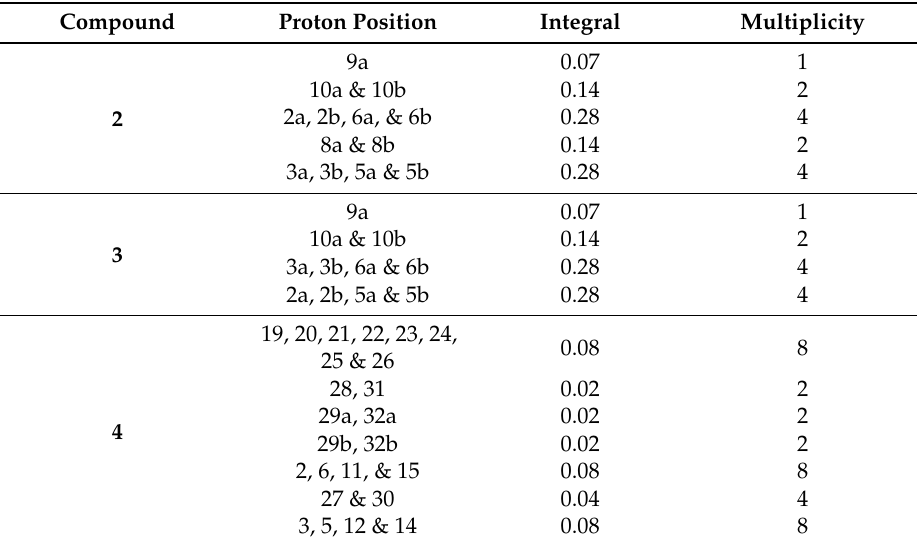
Figure 4. HSQC-NMR for the azacrown polyether macrocycle. Table 2. Proton NMR signal integration for compounds 2 – 4